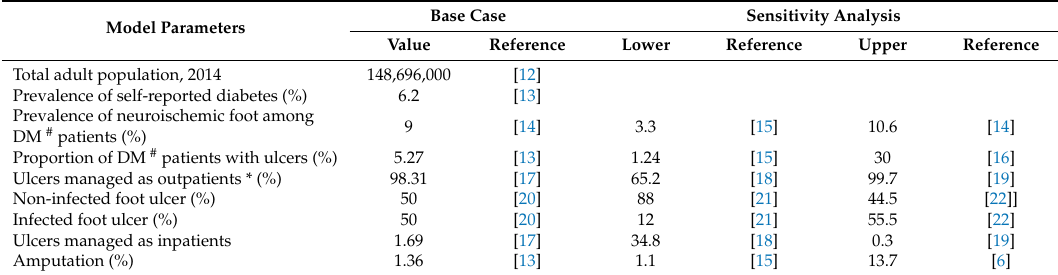
Table 1. Epidemiology model parameters—Base case and sensitivity